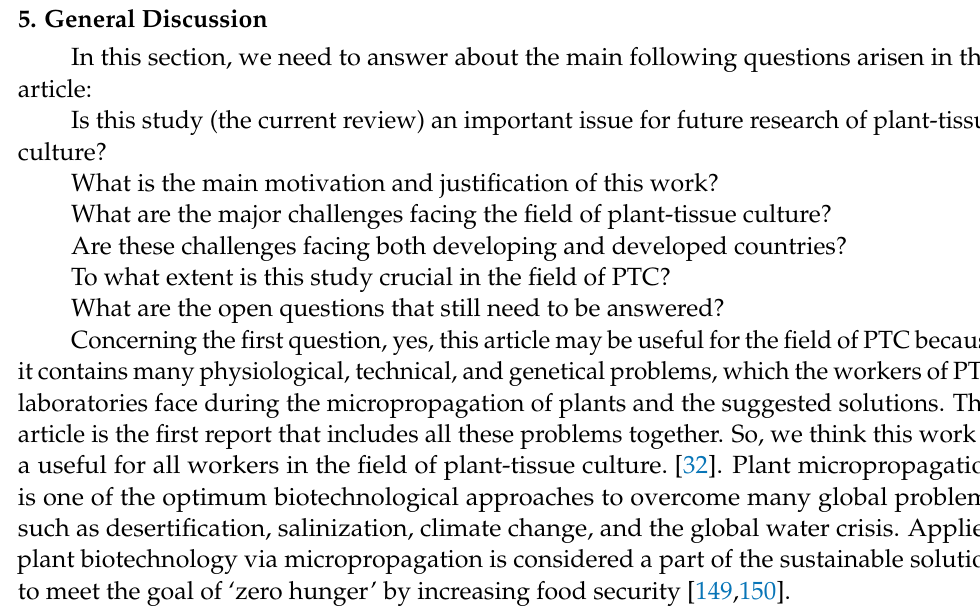
Figure 10. Effect of in vitro plant habituation on growth and rooting induction. ( A ) Habituated rooted Cordyline terminalis plant, ( B ) non-habituated Cordyline terminalis , ( C ) habituated rooted Aglaonema sp. plant, and ( D ) non-habituated non-rooted f Aglaonema sp. plants maintained in the absence of cytokinin for 6 weeks.